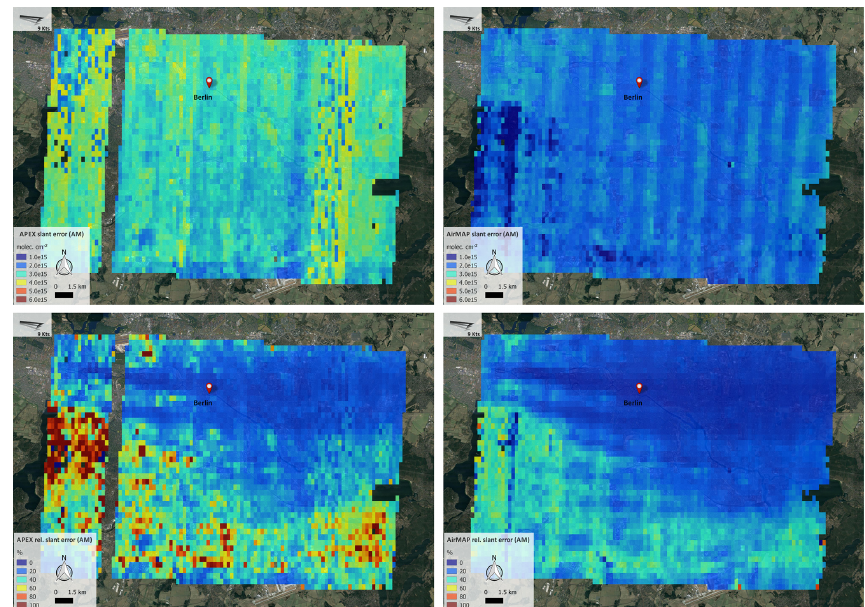
Figure 17. Distribution of the errors on the retrieved slant columns from APEX and AirMAP observations (upper panel) and distribution of the relative slant errors for APEX and AirMAP retrievals (lower panel) for the morning flight over Berlin on 21 April 2016 (Google, TerraMetrics).